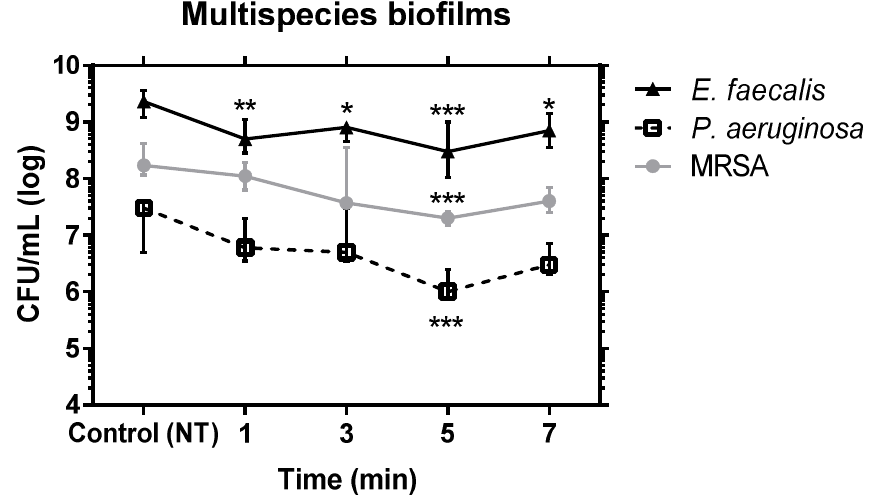
Figure 2. Median and interquartile range of MRSA, P. aeruginosa and E. faecalis viable cells (CFU/mL) recovered after exposure of multispecies biofilms to CAP for 1, 3, 5 and 7 min. Kruskal–Wallis test and Dunn’s multiple comparison post hoc test * p < 0.05; ** p < 0.01; *** p < 0.001.